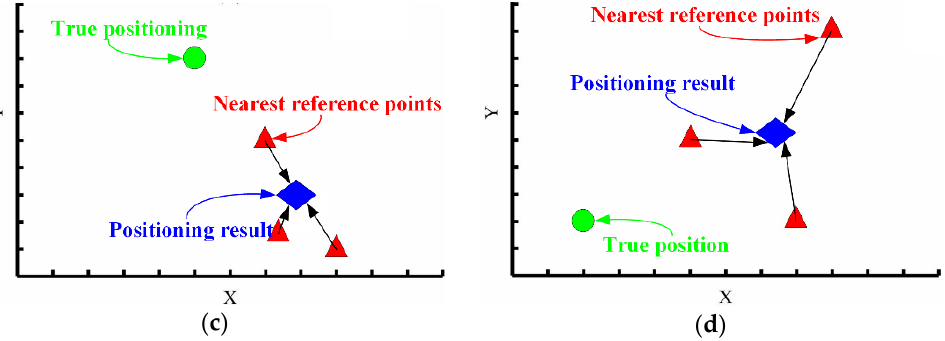
Figure 1. Examples of unreliable nearest RPs. ( a ) two nearest RPs away from true position, ( b ) one nearest RP away from true position, three nearest RPs away from true position in ( c ) and ( d ).